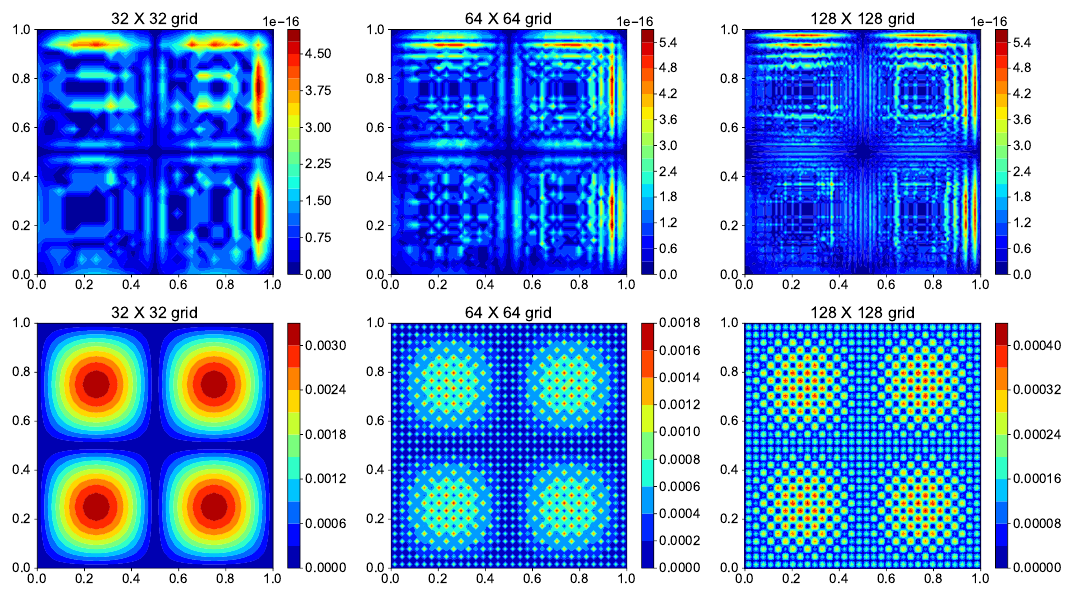
Figure 17. Comparison of error for spectral method (Top) and second-order CDS (bottom) for three different grid resolutions. The error is defined as (cid:101) ( x , y ) =